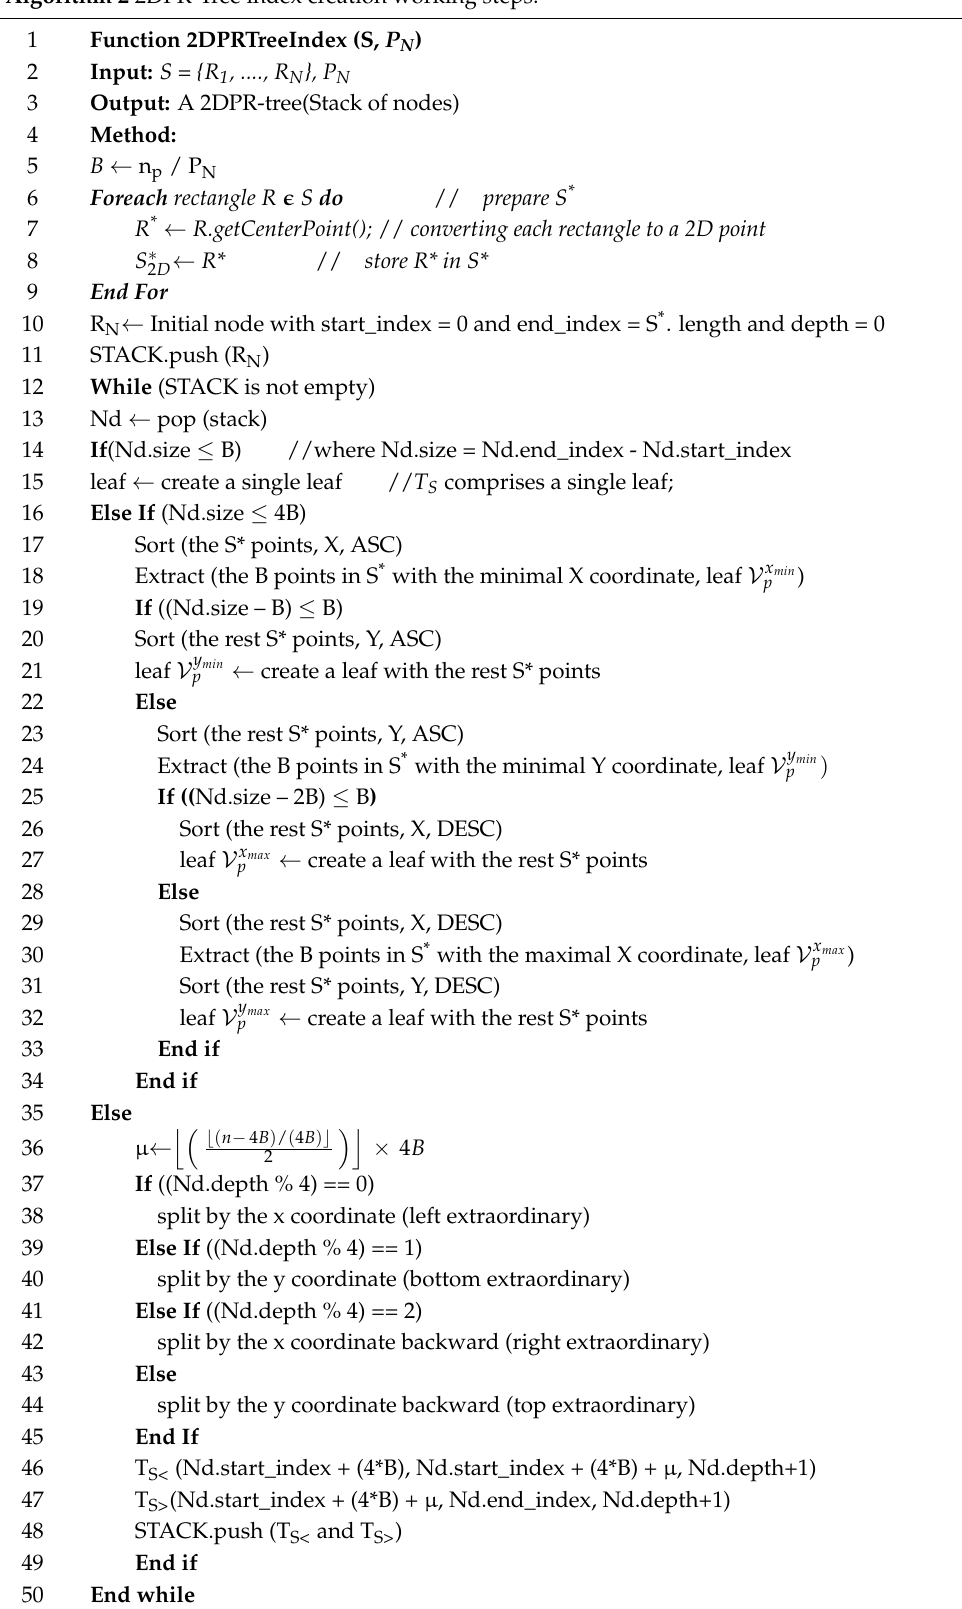
Algorithm 2 2DPR-Tree index creation working